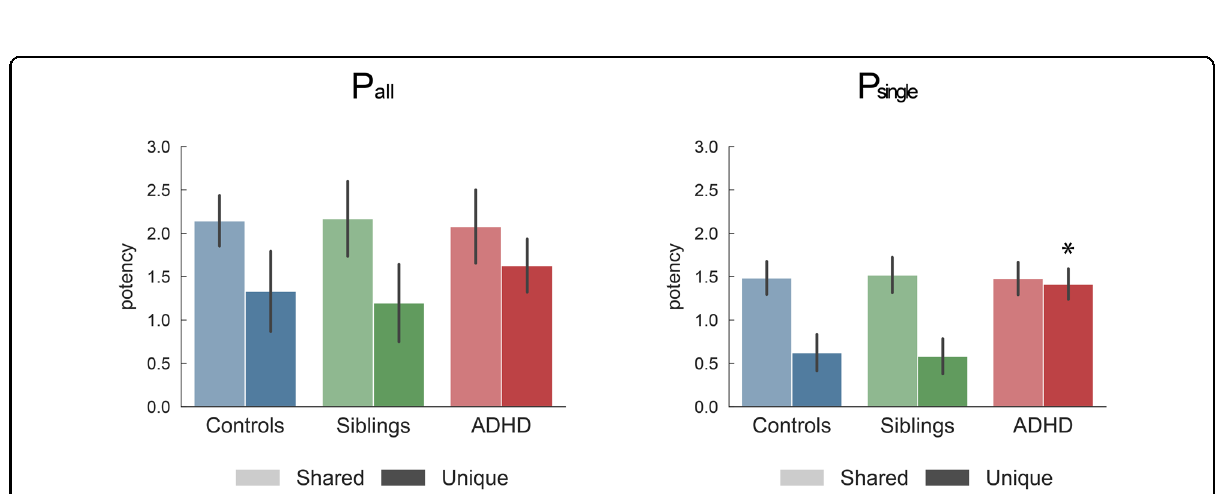
Fig. 4 Modulation of edges. The graphs quantify the average task potency across unique or shared connections for each group and connection type (corresponding to the third line in Fig. 1). All reported values show the average and standard deviation across 10,000 independent bootstraps. Indicated P values show signi fi cant differences after FDR correction. Full results are available in Tables S3 and S7. Replication of these fi ndings in light of possible confounding effects (scanner, gender, medication, comorbidity, age, IQ) is available in Figs. S1 and